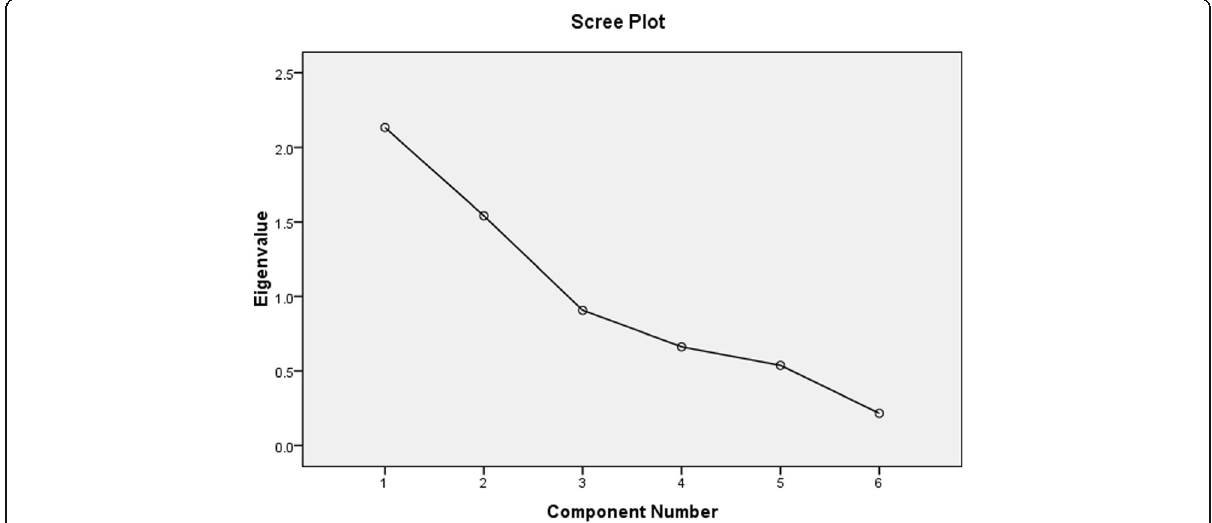
Fig. 9 Scree plot of eigenvalue of principal components for forest